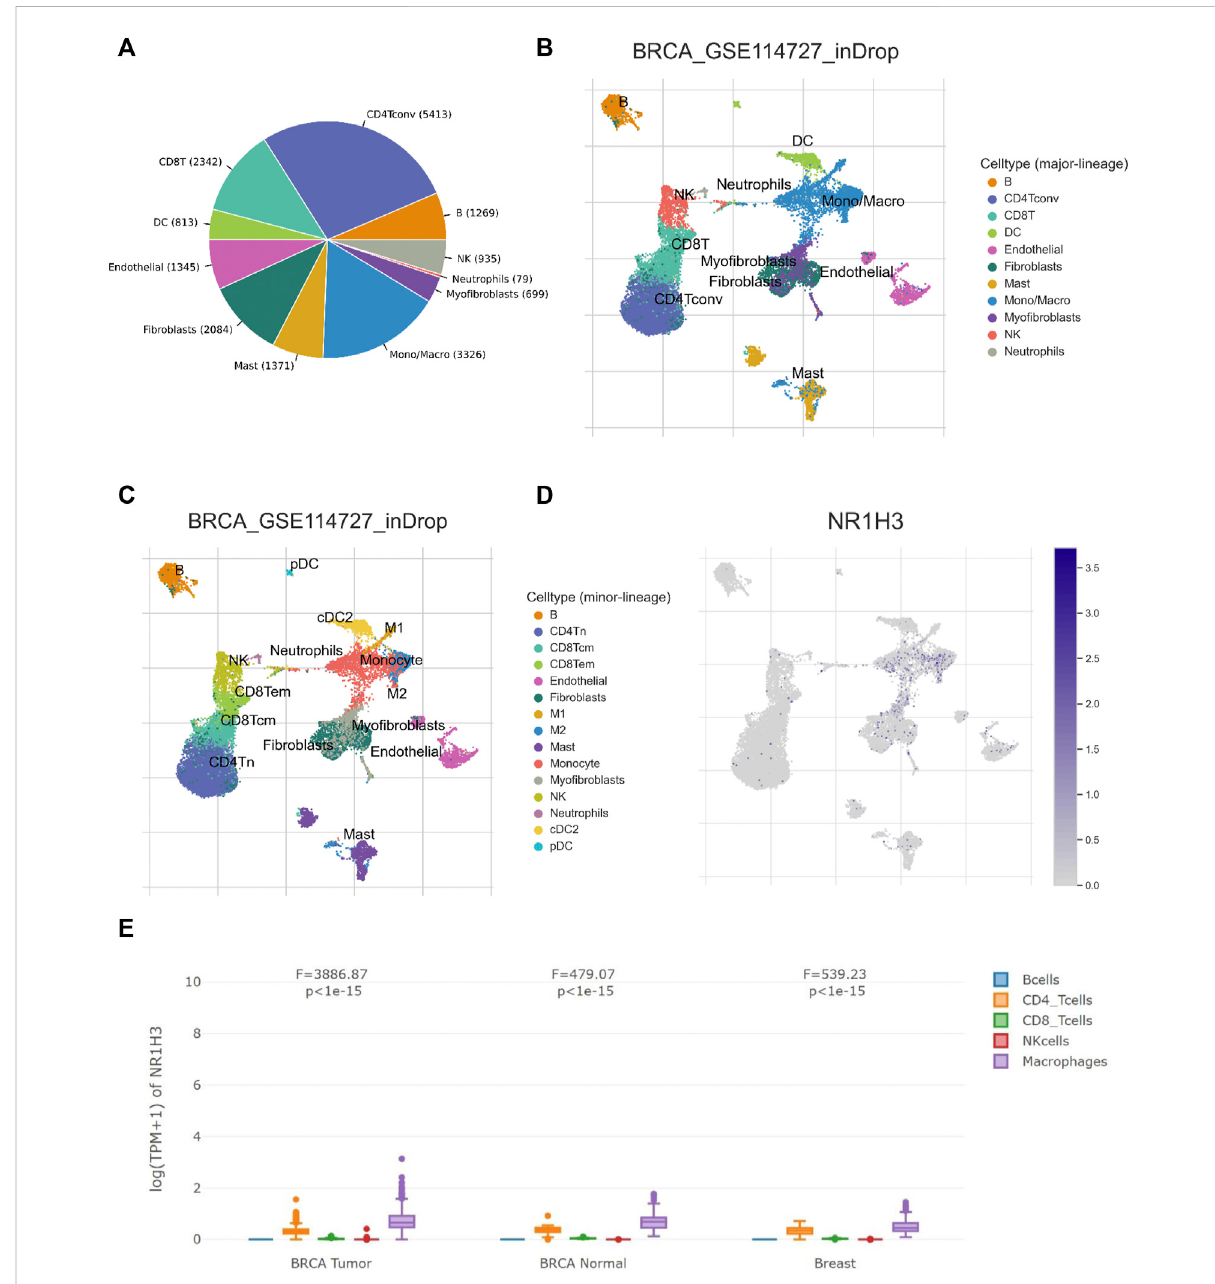
FIGURE 6 NR1H3 expression in TME-related cells. (A – C) The TME cell types and distribution in the GSE114727_inDrop dataset. (D) The distribution of NR1H3indifferentcelltypeswasanalyzedusingsingle-cellresolutionintheGSE114727_inDropdatasetusingtheTISCHdatabase. (E) Comparisonof NR1H3 expression distribution across samples in BRCA Tumor/BRCA normal from TCGA and breast tissue from GTEx. TME, tumor microenvironment; TISCH, Tumor Immune Single Cell Hub; BRCA, breast invasive